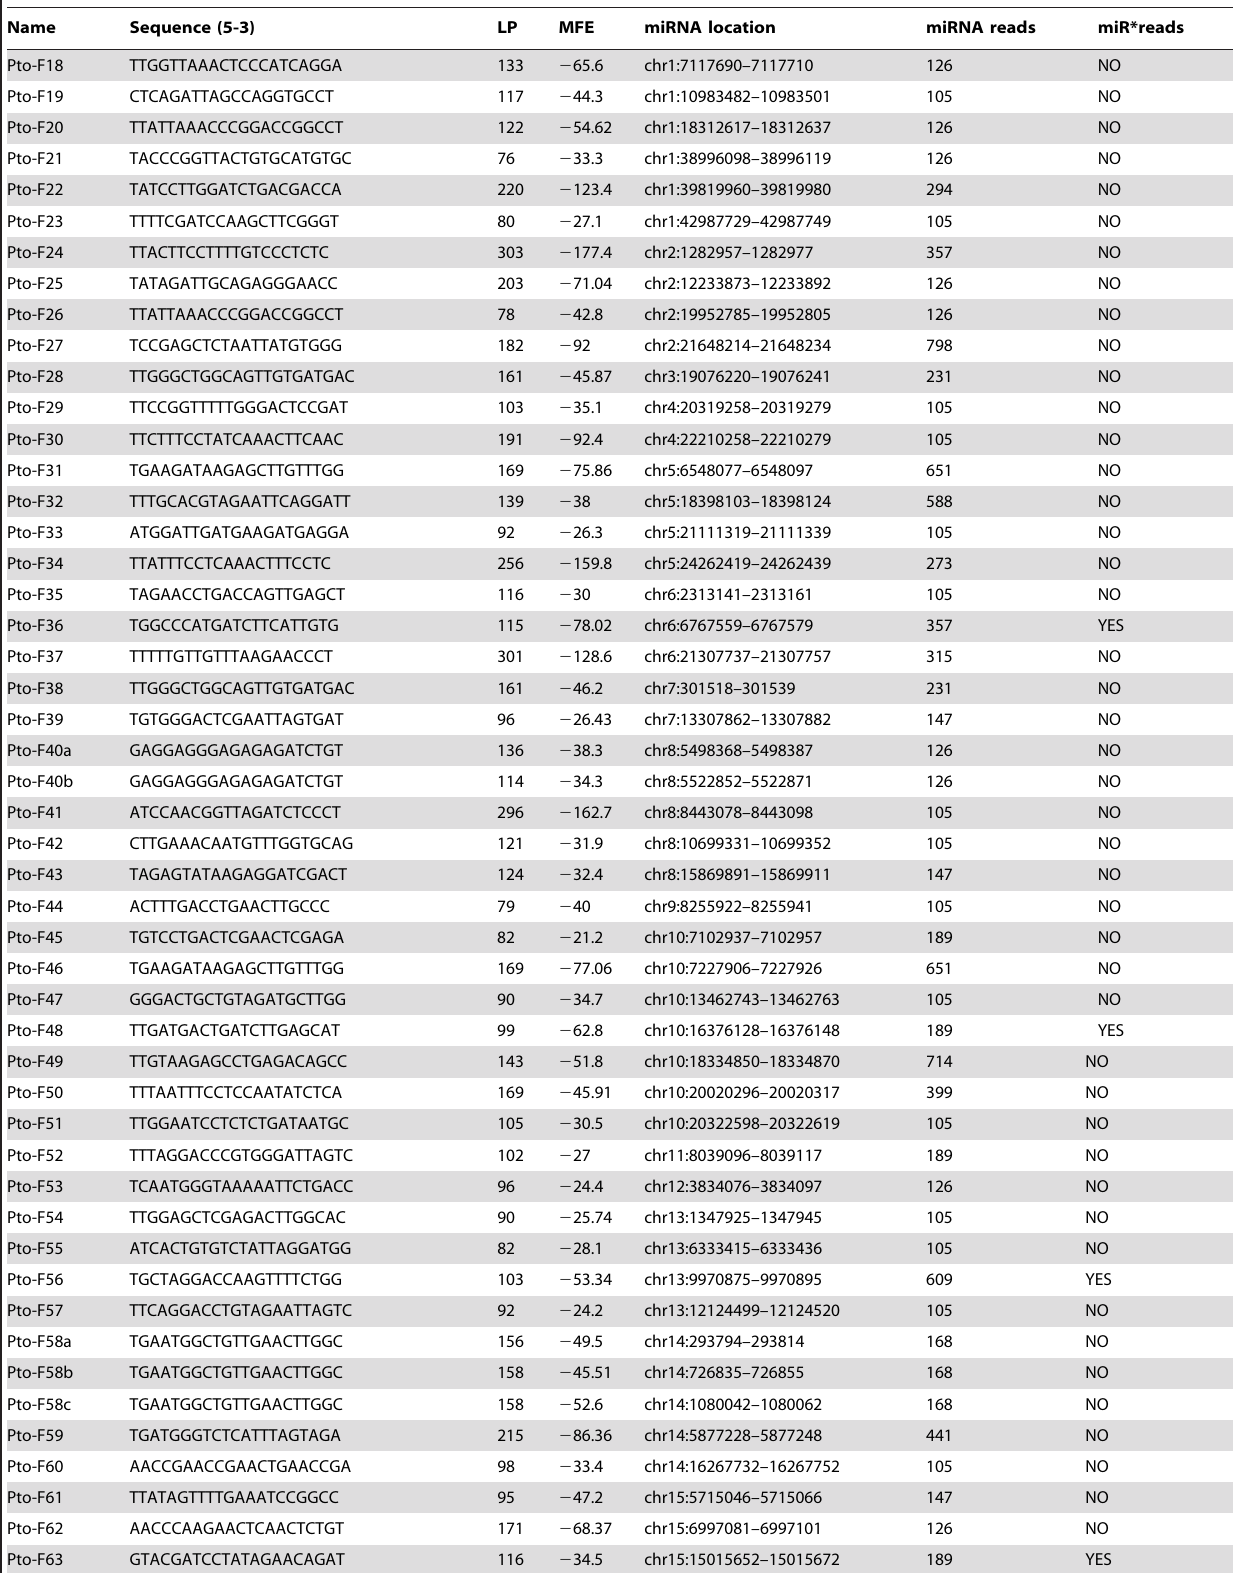
Table 5. Summary of female-specific novel